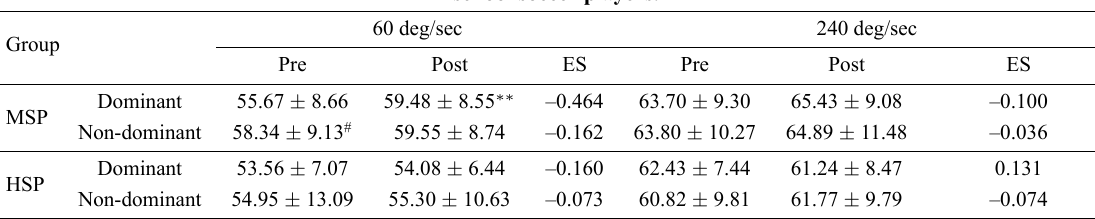
Table 5. Hamstring-to-quadriceps ratio for dominant and non-dominant side by two weeks of training on middle and high school soccer